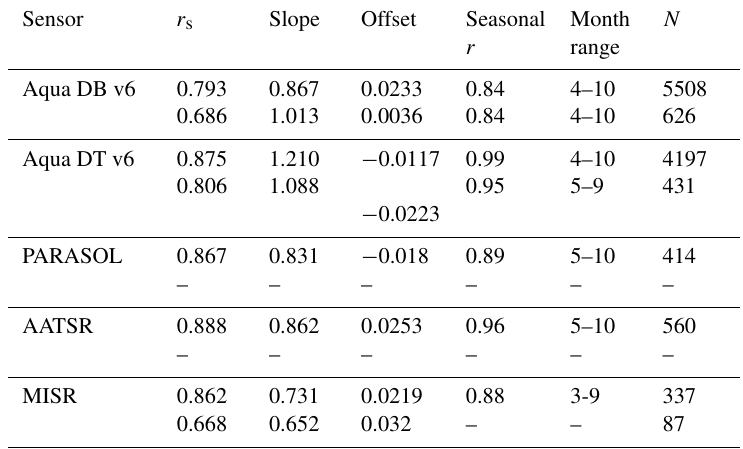
Table 4. Statistical comparison of coincident AODs observed by satellite-based sensors and AERONET Cimel sun photometers. For each satellite AOD product, the upper row is for Fort McMurray and the lower row is for Fort McKay. The Cimel 500nm AOD, scaled to the satellite AOD wavelength (see Sect. 2), is used for comparison with all satellite sensors except POLDER/PARASOL, for which the Cimel 870nm AOD is more appropriate (see Table 1). The number of MISR–Fort McKay coincidences is insufficient to assess the month-to-month variability.